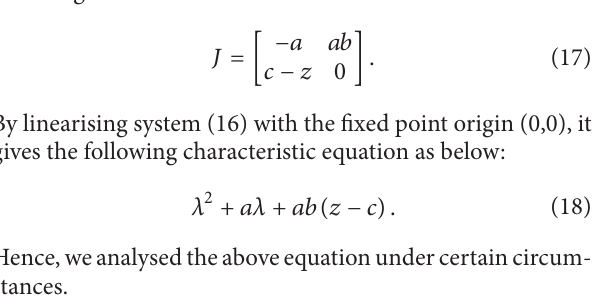
when , , 𝑦𝑦𝑧𝑧𝑧𝑧 𝑥𝑥 𝑥 10 𝑏𝑏 𝑥 𝑐.𝑏𝑐𝑏 𝑦𝑦 𝑥 20.𝑏1𝑏